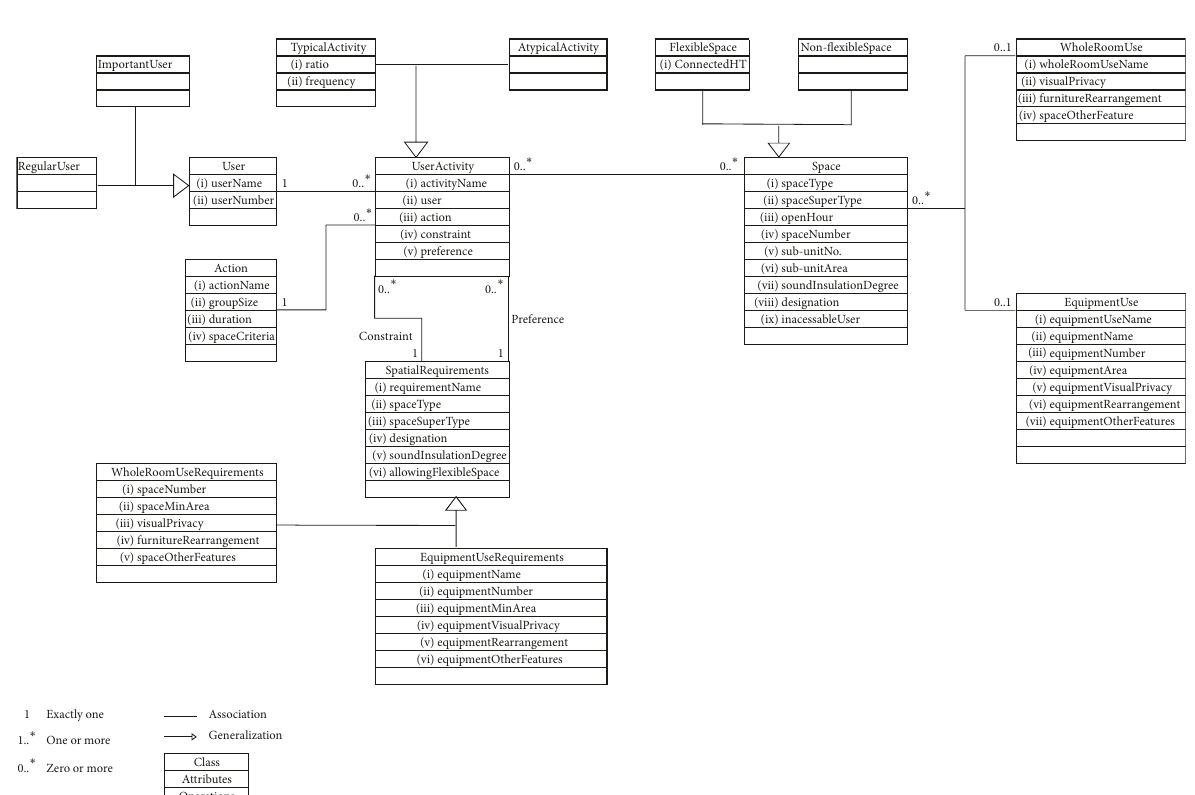
Figure 1: Flowchart of the research methodology.